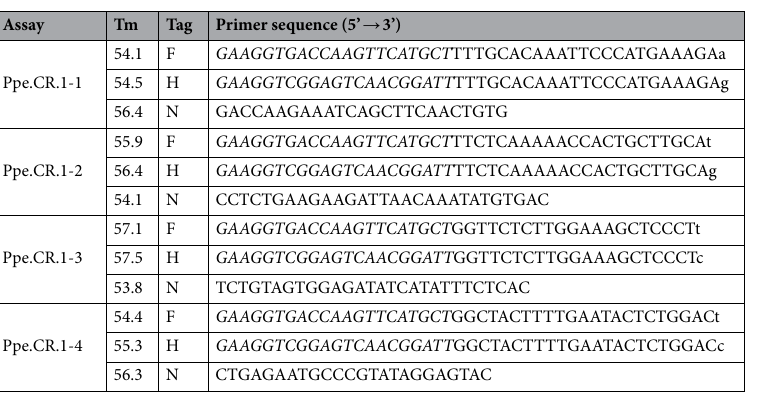
Table 3. Primer info for Kompetitive allele-specific PCR (KASP). Annealing temperatures (Tm, °C) and primer sequences for each assay, including FAM ( GAA GGT GAC CAA GTT CAT GCT ) and HEX ( GAA GGT CGG AGT CAA CGG ATT ) tag at the 5’ end of each forward primer. SNP nucleotide is shown in lower case in each forward primer sequence. ‘Tag’ indicates which fluorophore is used: ‘F’ = FAM, ‘H’ = HEX, ‘N’ = none, for the reverse